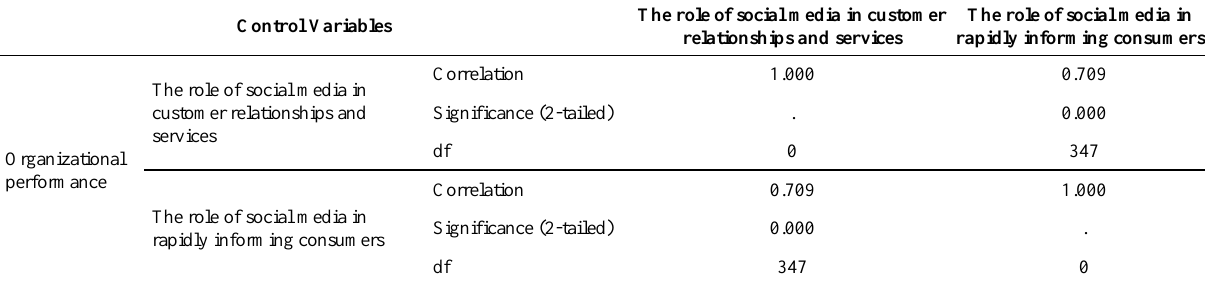
Table 6. Analyzes of correlation